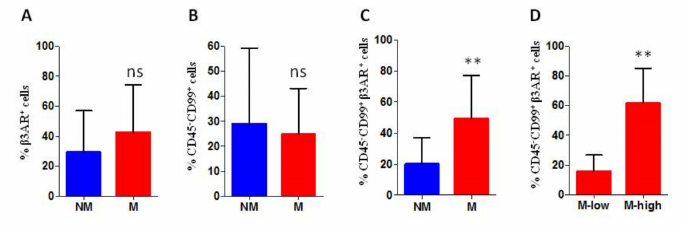
Figure 2. Cytofluorimetric (FACS) analysis of peripheral blood derived cells, the percentage of positive cells is reported. ( A ) percentage of beta-3-adrenergic receptor ( β 3-AR) positive cells within of all peripheral blood (PB) cells (% β 3-AR + cells range: Non-metastatic (NM) 11–58%; metastatic (M) 25–75%); ( B ) percentage of CD99 positive cells on the surface of CD45 − PB cells (% CD99 + cells range: NM 0–59%; M 8–43%); ( C ) percentage of β 3-AR positive cells on CD45 − CD99 + gated cells (% β 3-AR + cells range: NM 0–39%; M 5–80%); and ( D ) percentage of β 3-AR positive cells on CD45 − CD99 + gated cells analysed within the group of metastatic patients (% β 3-AR + cells range: Mhigh 37–80%; Mlow 5–23%). M low: M group with low β 3-AR expression level, and M high: M group with high β 3-AR expression level.